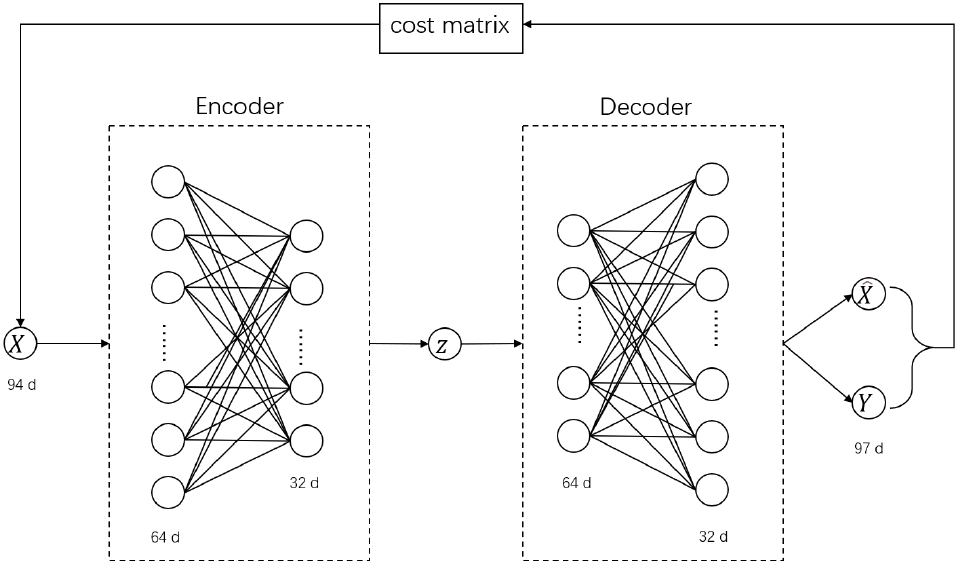
Figure 5. Structure of the cost-sensitive variational autoencoding classifier. Based on the variational autoencoding classifier, a cost-sensitive module is added to adapt to the imbalanced data. X represents the input data, Y represents the label of the input data, ˆ X represents the reconstruction of the input data, and z represents hidden